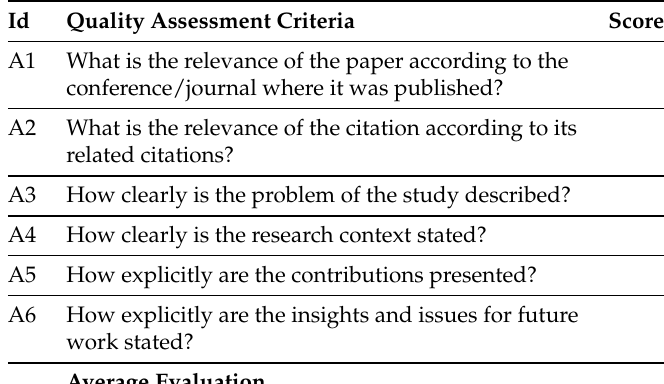
Table 12. Quality Assessment Scores